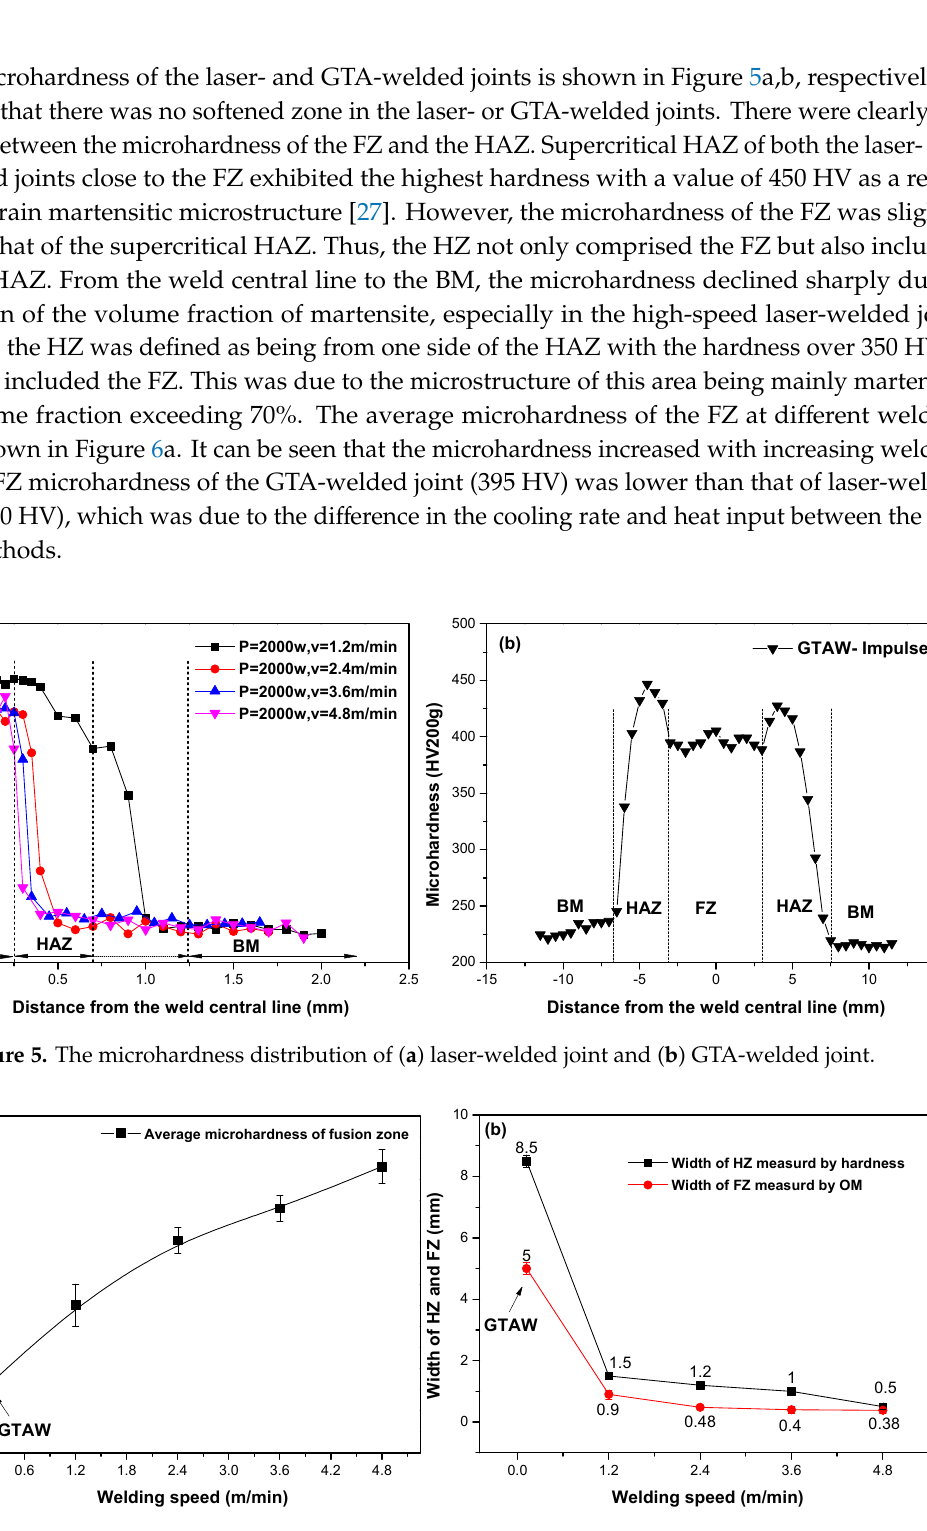
Figure 6. Microhardness and width of the FZ and HZ at different welding speeds: ( a ) average microhardness of the FZ and ( b ) width of the FZ and HZ.